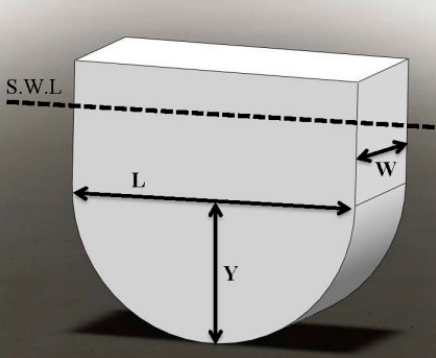
Figure 13. Pareto fronts for ( a ) the width and ( b ) the height of the triangular part of the bottom chamfered shape.